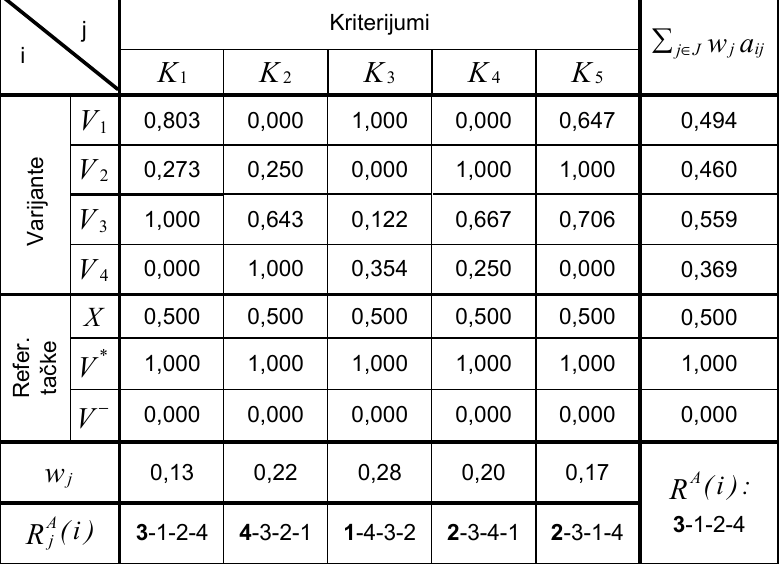
Table 2 – Matrices of the normalised criteria values }{A a